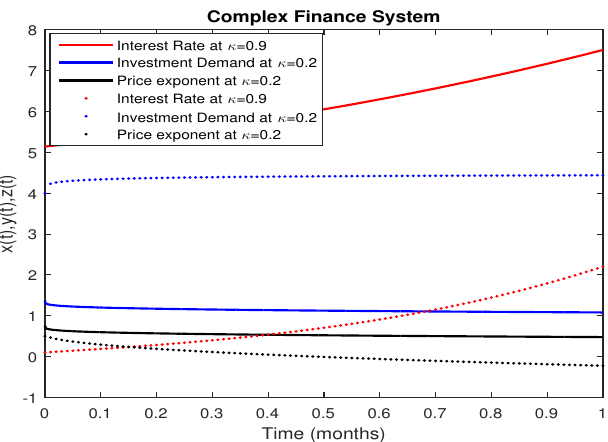
Figure 10. z ( t ) price exponent with Caputo and ABC derivative.